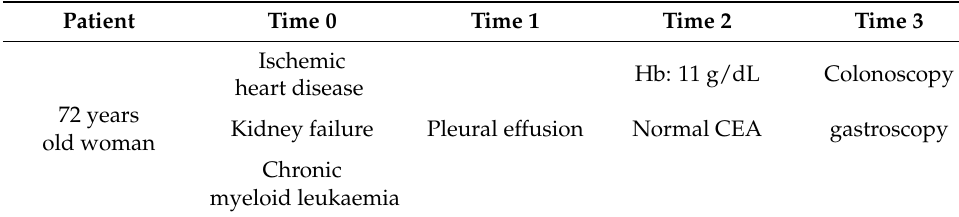
Table 1. Summary of clinical history of the patient.